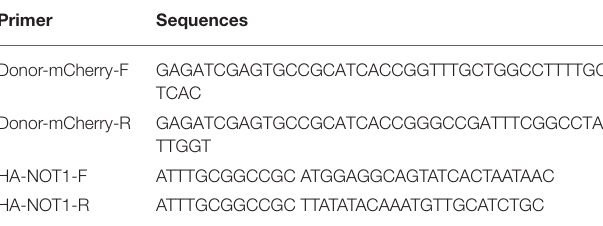
TABLE 2 | Primer sequences used for donor template